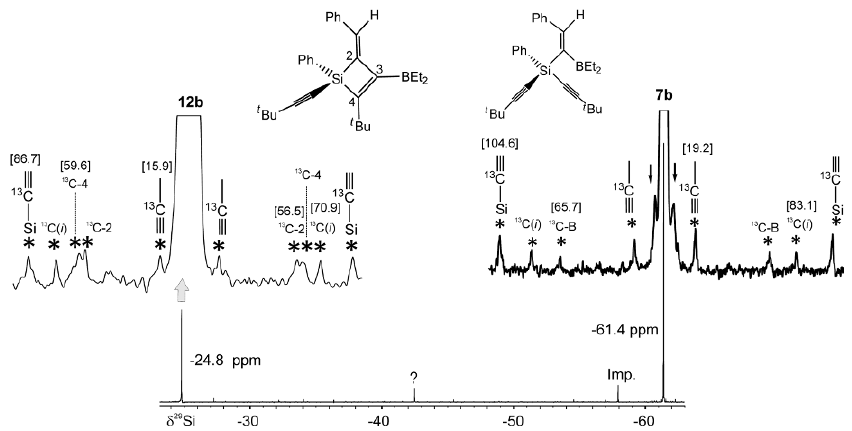
Figure 2. 29 Si{ 1 H} NMR of the mixture containing 7b and 12b . Expansions are given for corresponding signals showing 13 C satellites marked by asterisks representing 1 J ( 29 Si, 13 C) and 2 J ( 29 Si, 13 C). The satellites close to the parent signal of 7b , marked by arrows (5.9 Hz) may arise due to n J ( 29 Si, 13 C) n ≥